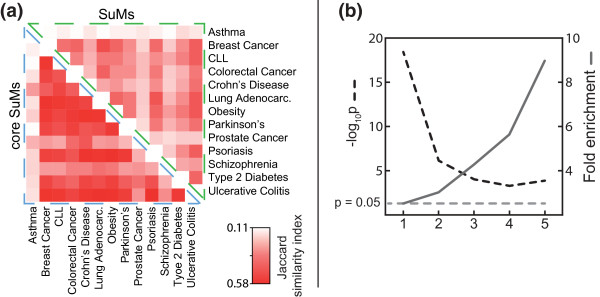
Similarity of core SuMs of different diseases and enrichment of disease genes in the union of core SuMs. (a) Heatmap showing that core SuMs are more similar than SuMs. The color intensity represents similarity, defined by computing the ratio between the number of genes shared by two SuMs and the total number of genes in the two SuMs (Jaccard similarity index). (b) In an extended analysis of GWAS genes of 145 other diseases, the union of the core SuMs was enriched with GWAS genes. This enrichment increased with disease gene pleiotropy. CLL,.